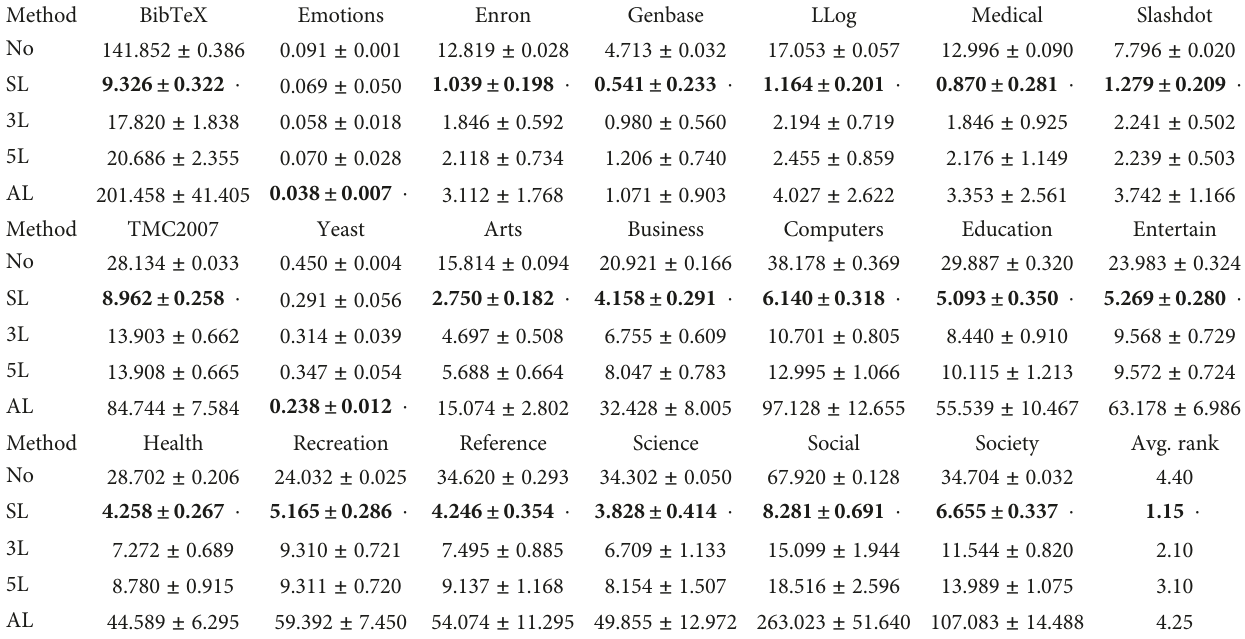
Table 2: Execution time ( ↓ ) for training and testing process of each comparing method (mean ± std. deviation) on 20 multilabel